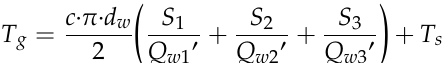
Table 1. Experimental setup in infeed cylindrical grinding.